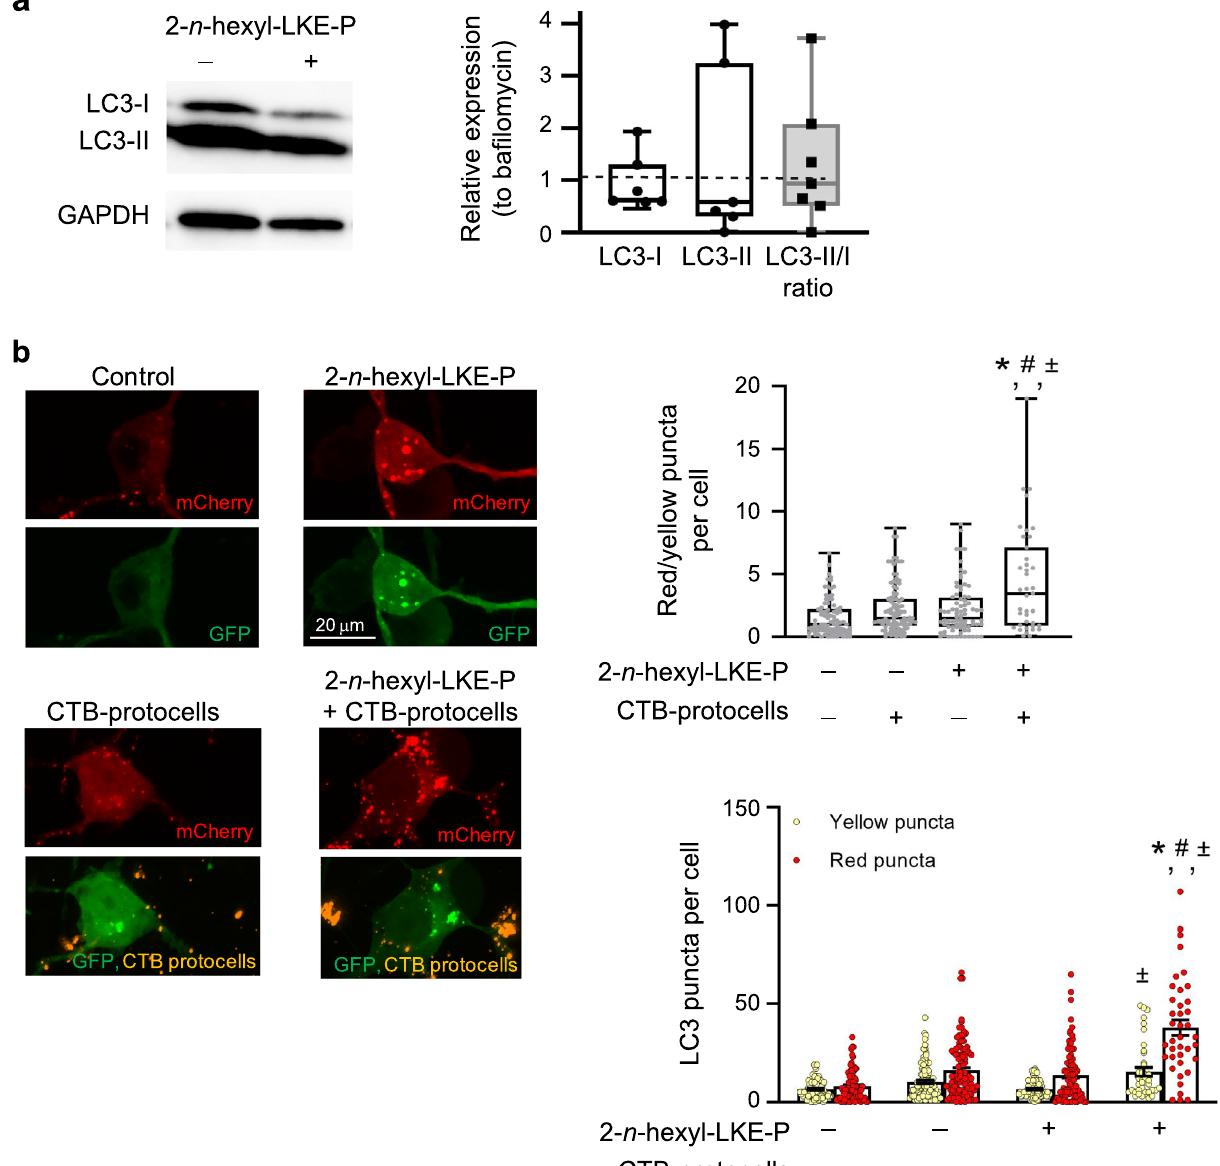
Figure 5. Changes of autophagy flux in motor neurons treated with 2- n -hexyl-LKE-P or CTB-protocells loaded with 2- n -hexyl-LKE-P. ( a ) Western blot analysis of LC3-I, LC3-II or the ratio after 2- n -hexyl-LKE-P treatment in the presence of bafilomycin compared to bafilomycin alone. Original uncropped blots are presented in Supplementary Fig. S5. Data are presented as a box plot, with the box extending from the 25th to 75th percentiles, the middle of the box at the median, and the whiskers at the minimum and maximum values. Each point represents protein expression from NSC-34 cells from a well of a 6-well plate; ( b ) Representative confocal images of NSC-34 cells transfected with mCherry-GFP-LC3 plasmid and treated with 2- n -hexyl-LKE-P or CTB-protocells containing 2- n -hexyl-LKE-P. Number of red-only puncta/cell as well as the number of yellow puncta/cell was quantified in different treatment groups. n = 5 biological samples with a minimum of 20 cells per sample. Data are presented as mean ± standard deviation of the mean. Each point represents a single cell. *, significantly different than control treatment (p < 0.05); # , significantly different than control CTB-protocell treatment; ± , significantly different than 2- n -hexyl-LKE-P Compared to treatment with bafilomycin (Fig. 5a), 2- n -hexyl-LKE-P treatment in the presence of bafilomycin did not result in an overall change in the relative expression of LC3-I or LC3-II (F 1,28 < 1; p = 0.88 and F 1,28 < 1; p = 0.70). In the presence of bafilomycin, 2- n -hexyl-LKE-P treatment also did not affect the ratio of LC3-II to LC3-I (F 1,28 < 1; p = 0.46). Autophagy flux analysis using the mCherry-GFP-LC3 plasmid showed an effect on red/yellow puncta per cell of 2- n -hexyl-LKE-P when delivered using CTB protocells. Post-hoc Tukey analysis showed that autophagy flux